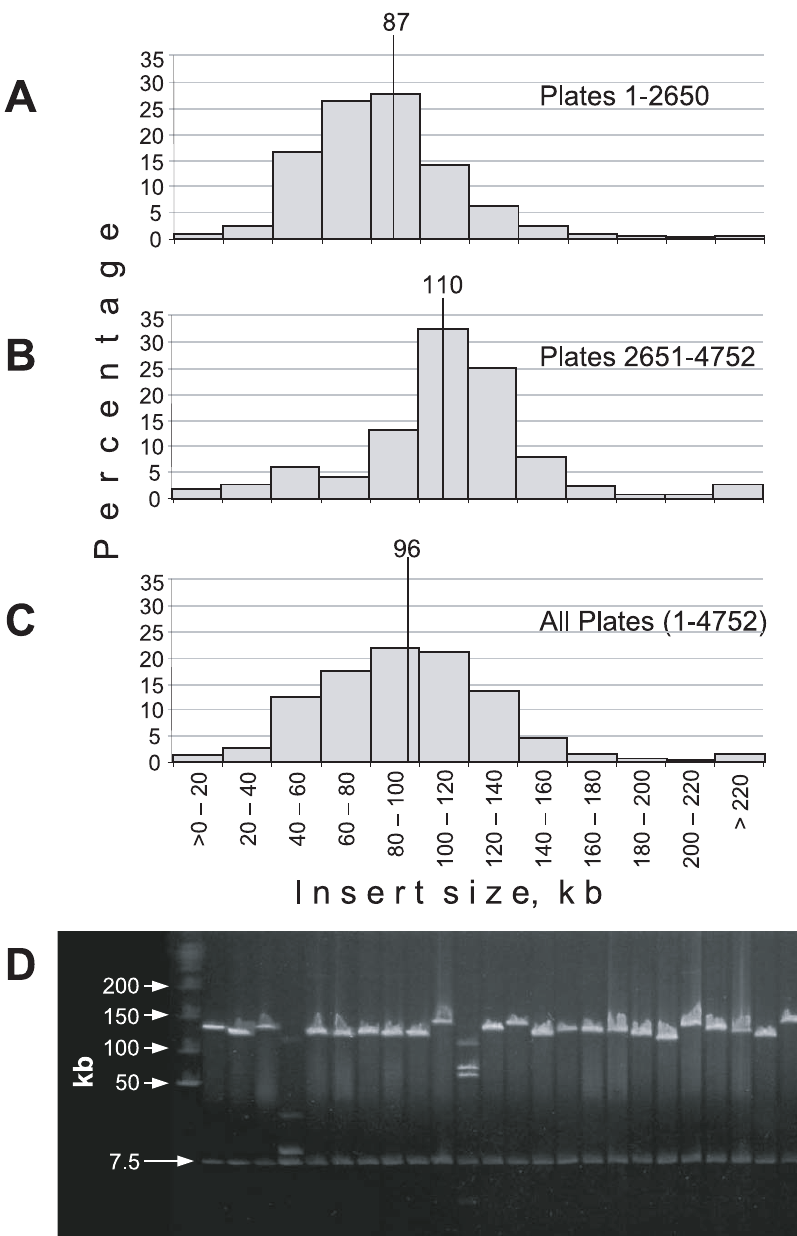
Figure 2. Inserts of LP 7-56 BAC clones. Insert size distribution of clones from (A) plates 1-2650, (B) plates 2651-4752, and (C) the library as a whole. (D) A typical agarose pulsed-field gel showing Not I digests of clones from the latter half of the library. The New England Biolabs PFGE Lambda Ladder is in the lane at the far left. A 7.5 kb vector band is visible at the bottom of each sample lane.